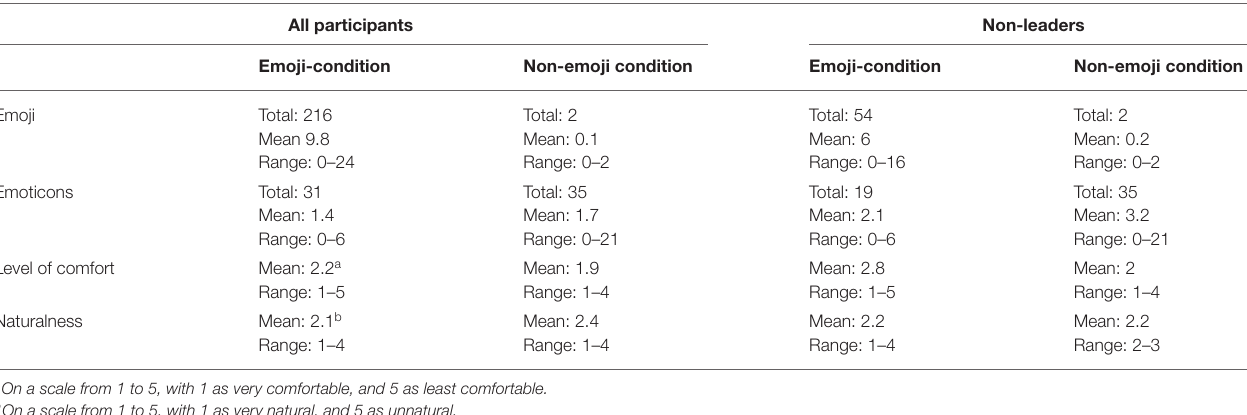
TABLE 4 | Overview of results.